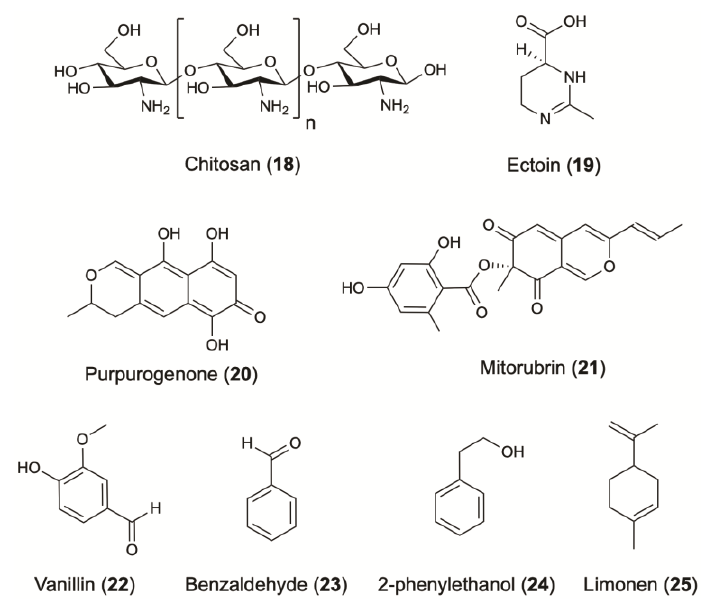
Figure 5. Additives and other active ingredients from terrestrial microorganisms.